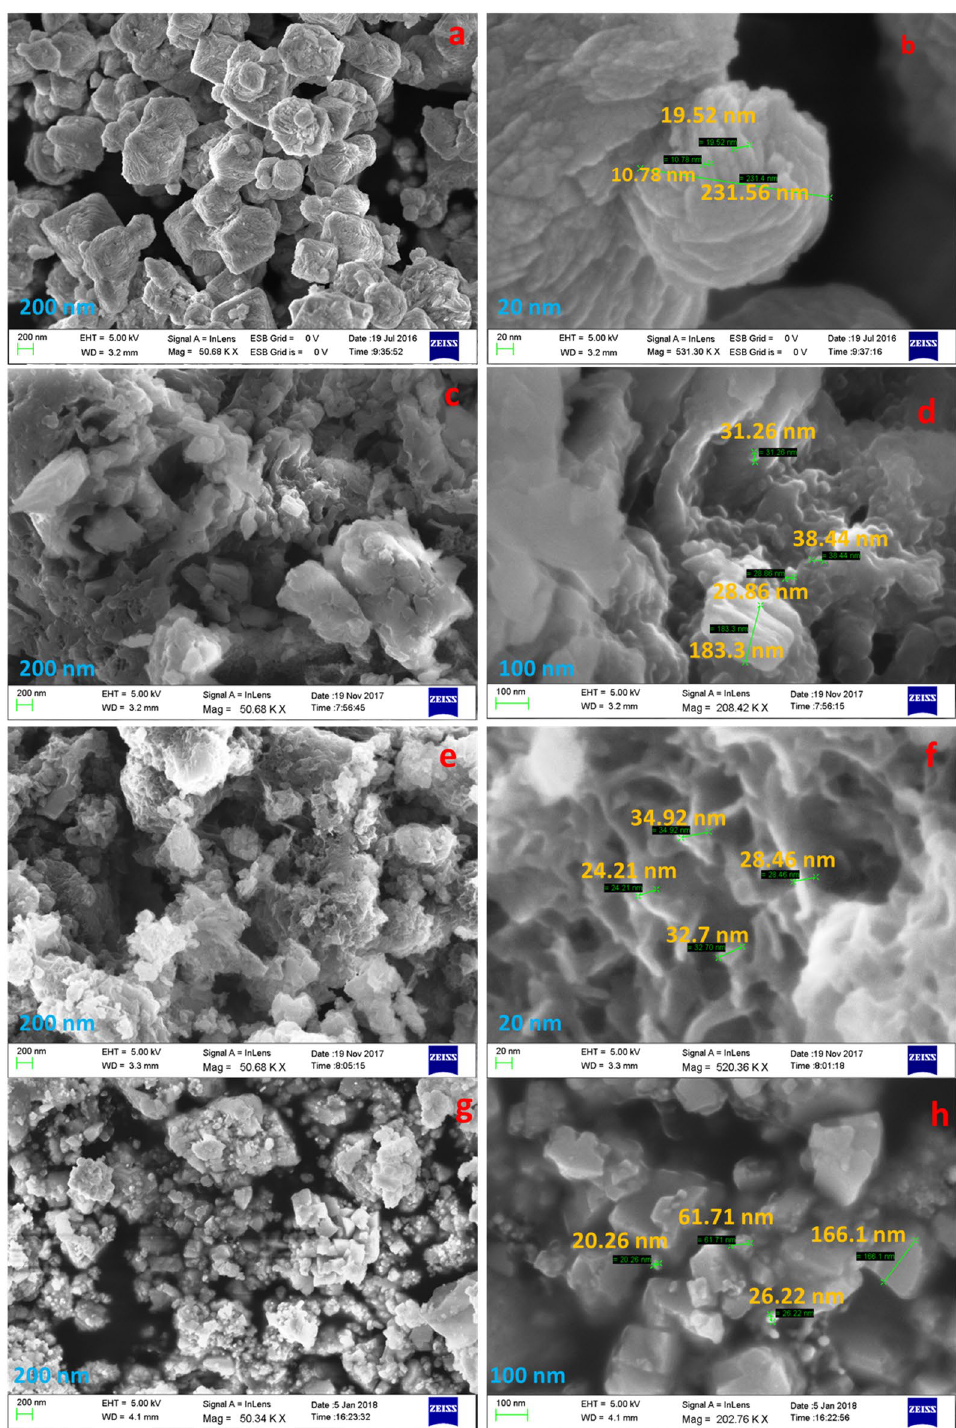
Figure 4. FESEM images of ( a , b ) Cu 2 O, ( c , d ) TANI, ( e , f ) TANI/Cu 2 O and ( g , h ) TANI/Cu 2 O/Ag